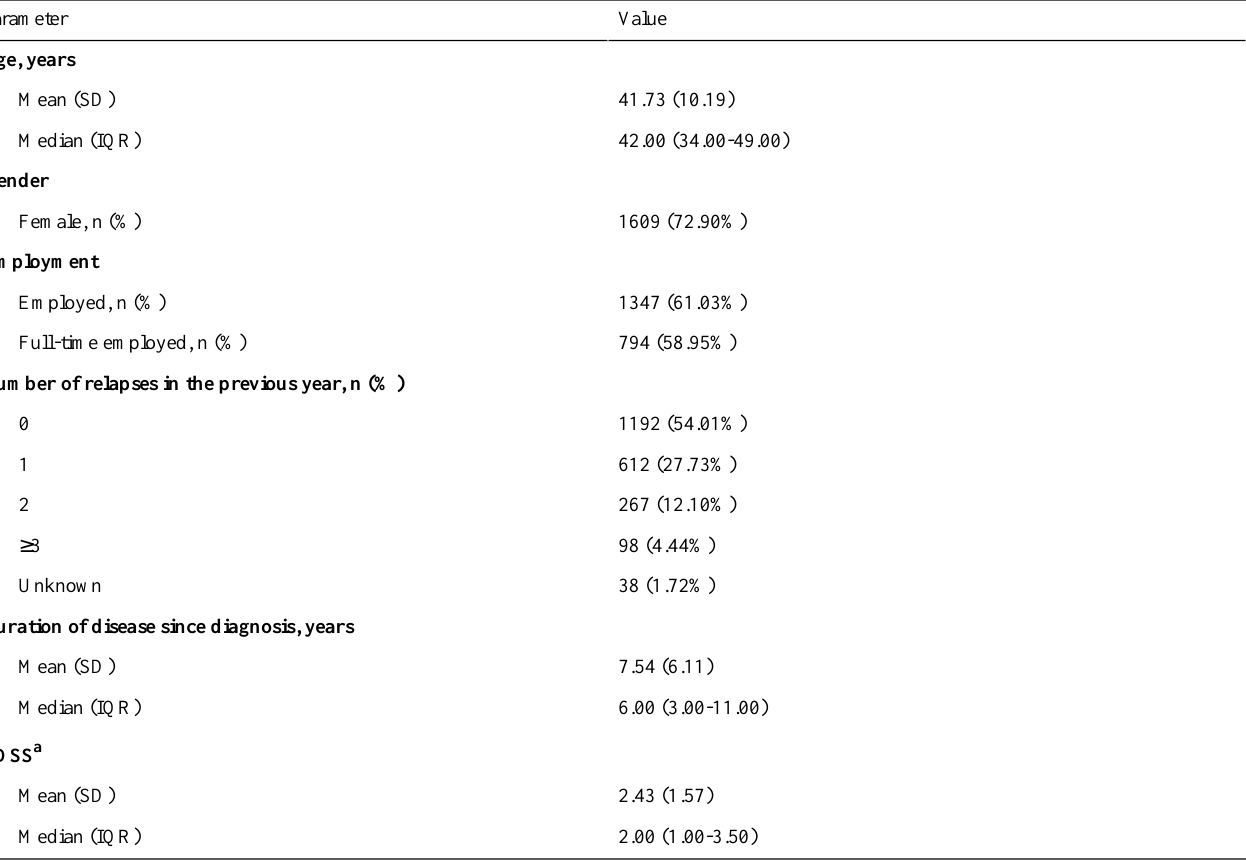
Table 5. Characteristics of the study population